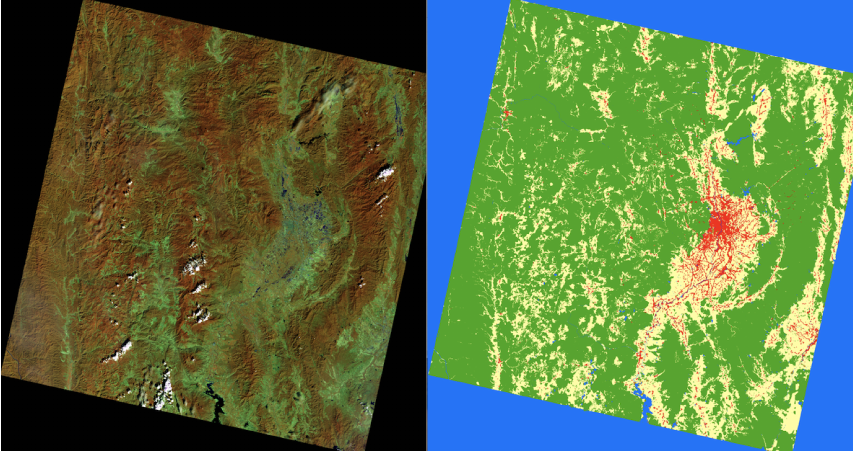
Figure 10. The zoomed predictions of the proposed method distinguishing urban from agriculture in the central region of Nan